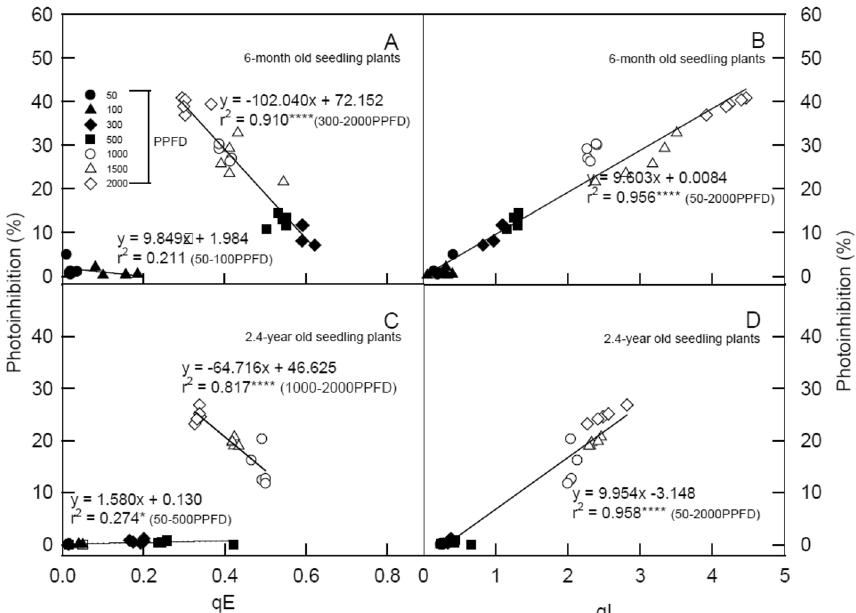
Fig. 4 Correlations between photo‑inhibition % to qE (panels A and C ) and qI (panels C and D ) in 6‑month (panels A and B ) and 2.4‑year seedlings (panels C and D ) of M. oiwakensis irradiated under 50, 100, 300, 500, 1,000, 1,500, and 2,000 μmol m − 2 s − 1 PPFD at 25 °C for 60 min. Each symbol represents the average of 5 leaves from one plant, and 5 plants were randomly selected from each light treatment. Each ChlF index was calculated using different seedling leaf data (n 7) from model validation datasets. The determination coefficient (r. 2 ) and significance of the regression are = shown (*, **, ***, **** p < 0.05, 0.01, 0.001,